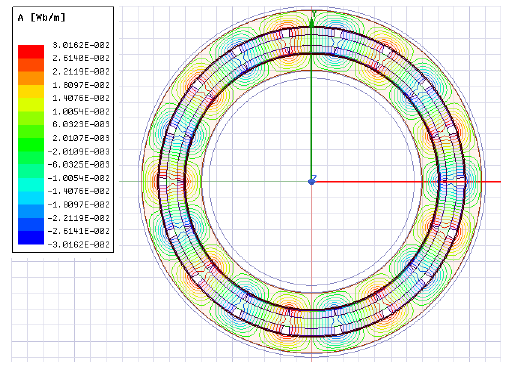
Figure 9. Cloud diagram of magnetic force line distribution.